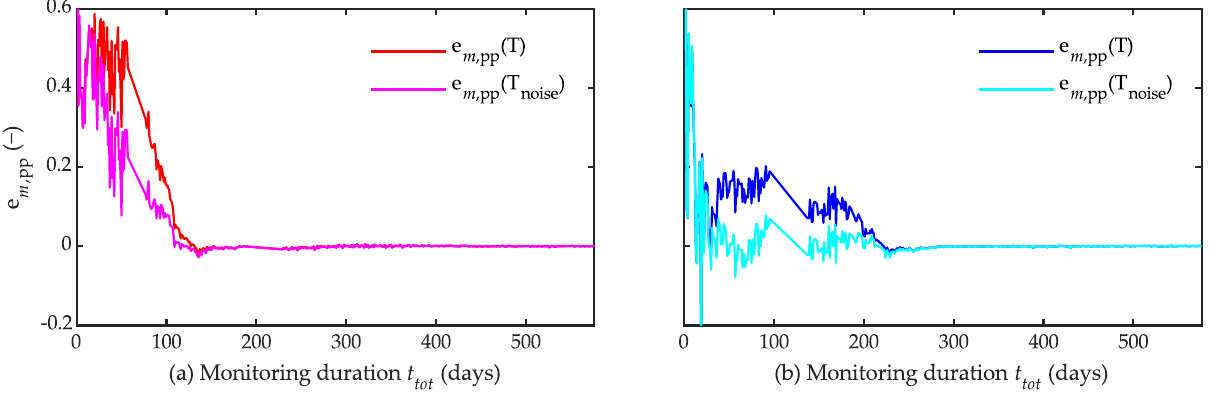
Figure 13. Error e m ,pp between the expected and the real uncertainty of the parameter m. The expected uncertainty is calculated with T and T noise . The monitoring start dates are ( a ) 20 April and ( b ) 20 July. σ m = 1 με/day = 365 με/year.